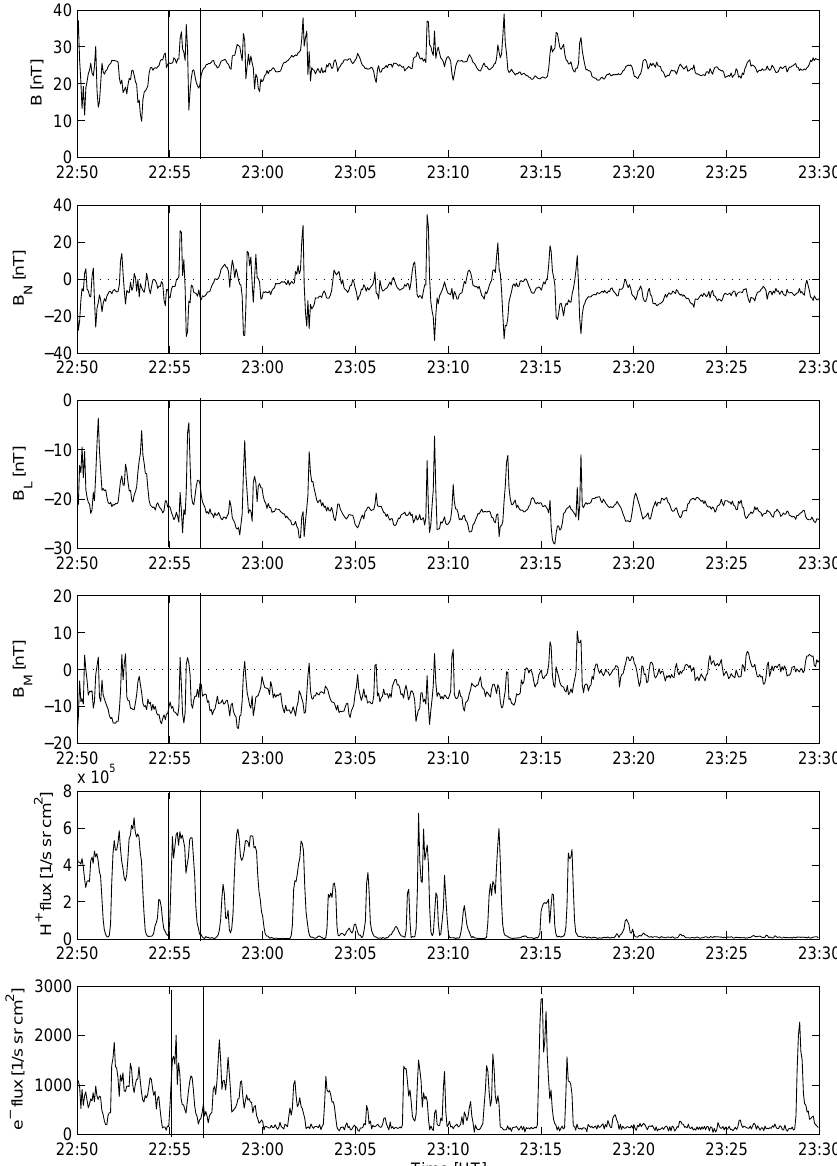
Fig. 2. Expanded view of Cluster 4 data in 22:50–23:30 UT. Panels from top to bottom depict the magnetic field intensity, the B N , B L , B M components (in boundary normal coordinate system where n = ( 0 . 352 , 0 . 379 , 0 . 856 ) in GSE system), and the total fluxes of energetic protons and electrons. The two vertical lines denote the time interval of the angular distribution in Fig.